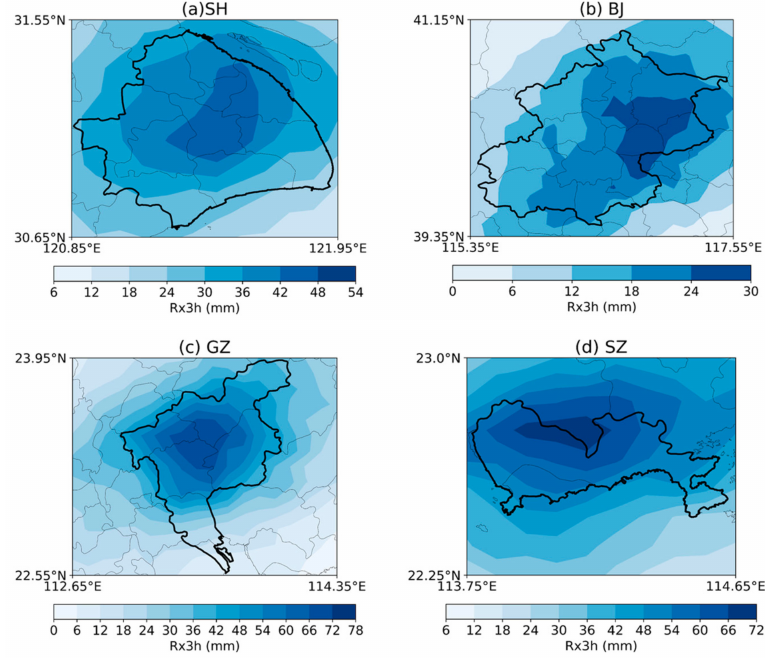
Figure 7. Maps of mean Rx3h in SH, BJ, GZ, and SZ